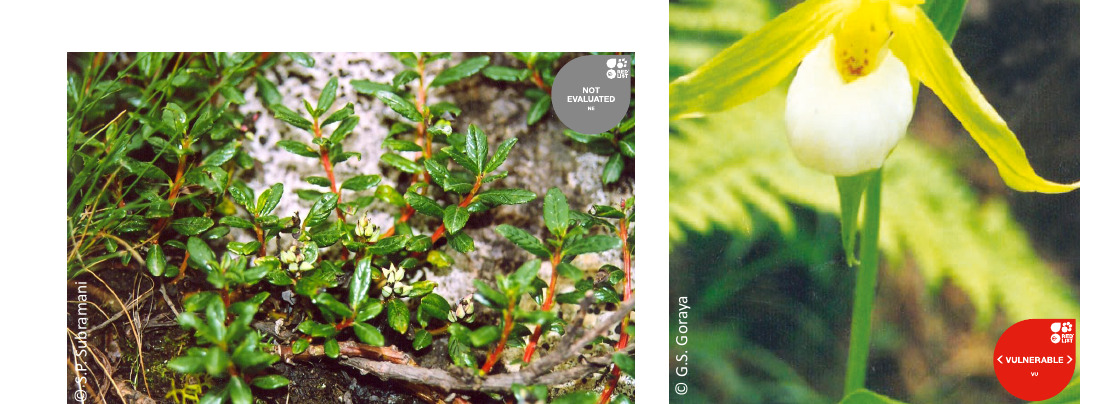
Image 18. Aconogonon rumicifolium (Royle ex Bab.) H.Hara